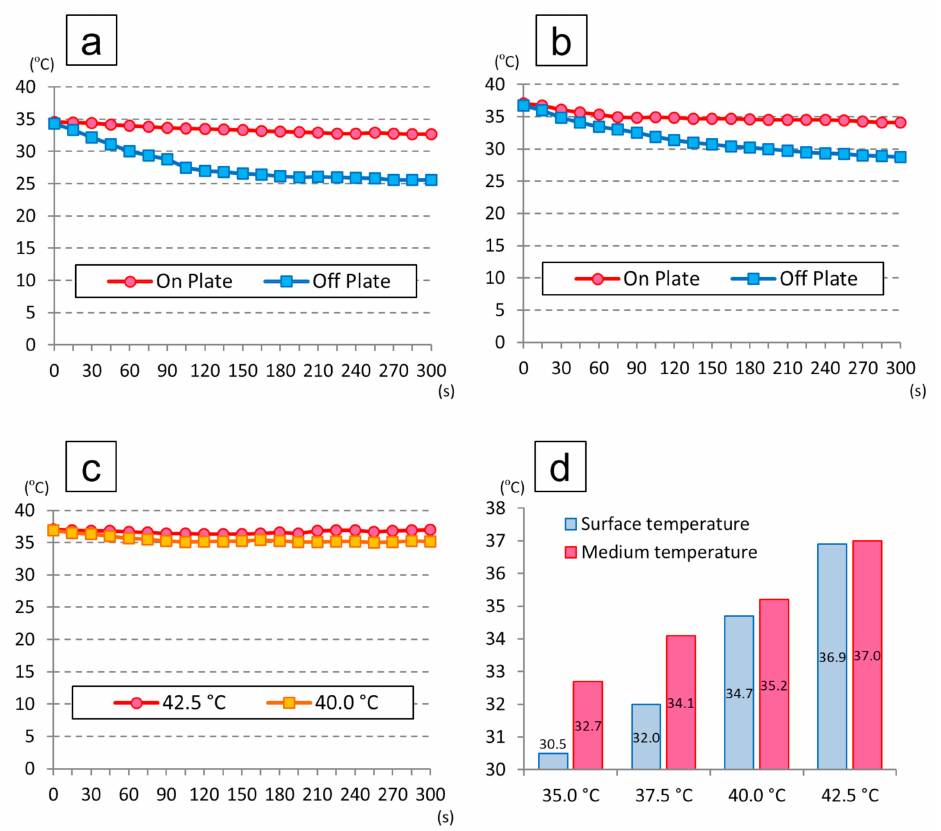
Figure 4. Temperature changes in the medium: ( a ) temperature changes of the dishes cultured at 35.0 ◦ C in an incubator; ( b ) temperature changes of the dishes cultured at 37.5 ◦ C in an incubator; ( c ) temperature changes when setting the temperature of the heat plate device at 40.0 ◦ C and 42.5 ◦ C; ( d ) temperatures of the adaptor surface and medium at 5 min when setting the temperature of the heat plate device at 35.0 ◦ C, 37.5 ◦ C, 40.0 ◦ C, and 42.5 ◦